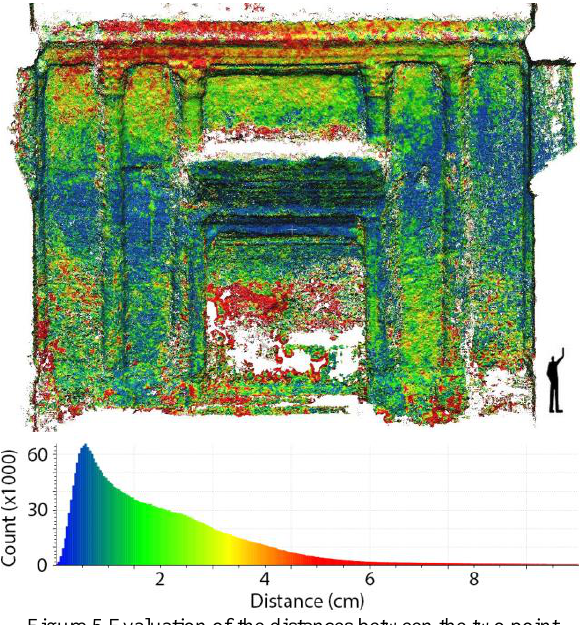
Figure 5 Evaluation of the distances between the two point clouds A (touristic imagery only) and C (touristic imagery combined with constraint panorama stations)